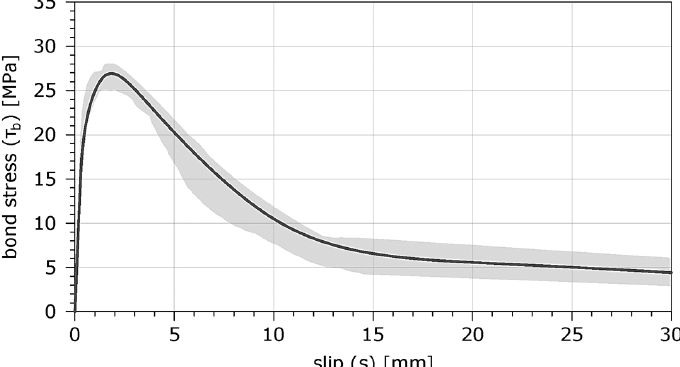
Figure 10. Bond stress–slip curve for POT-10 series (d b = 10 mm).